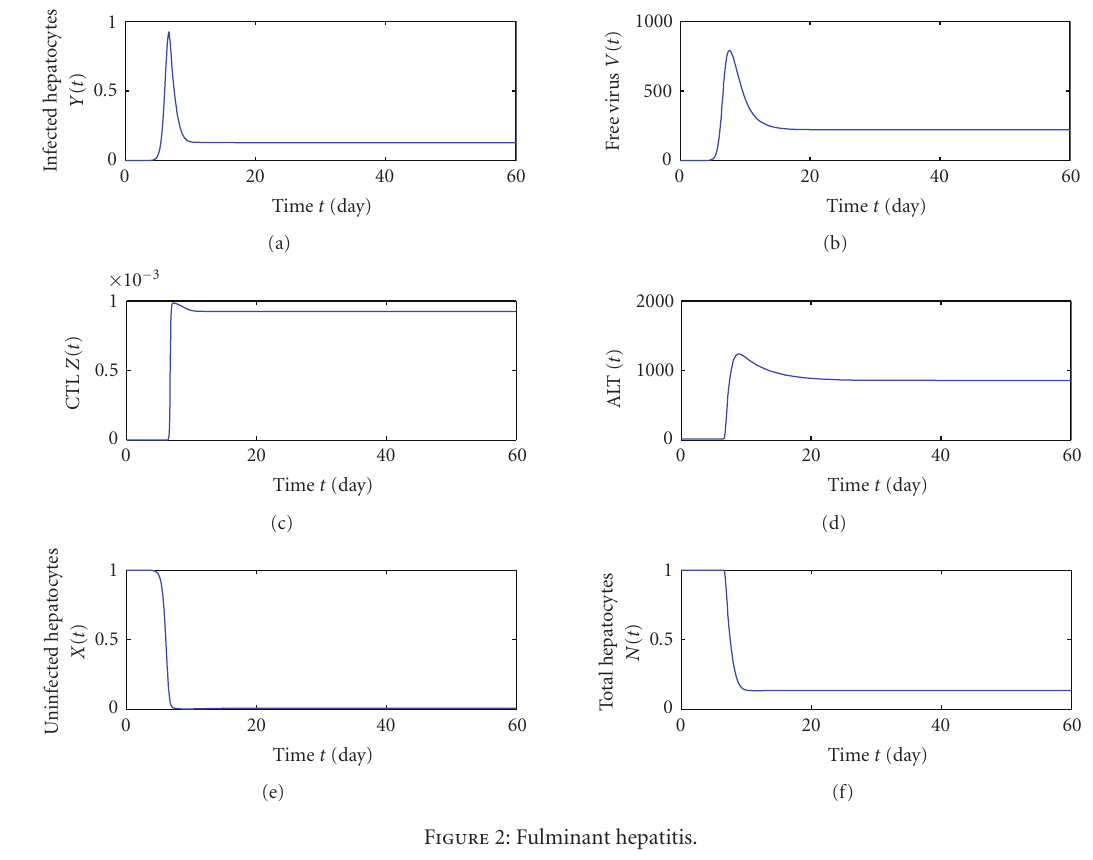
Figure 2: Fulminant